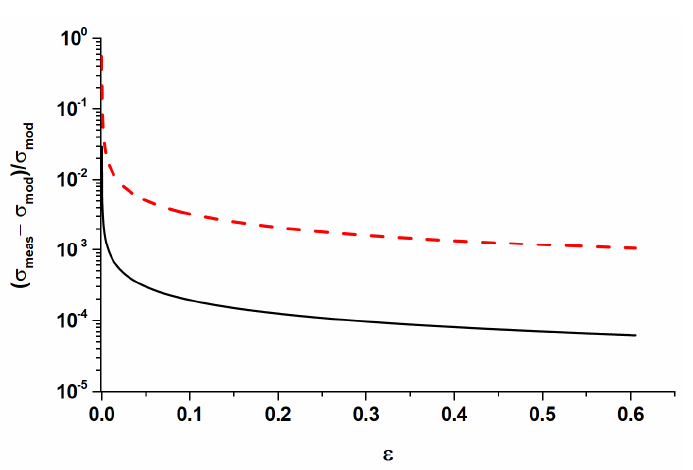
Figure 7. Effect of elastic and plastic terms in Equation (2) on the accuracy of FEM simulation: the continuous line takes into account both elastic and plastic parts, while the dotted line represents the simulation by considering only the plastic term.